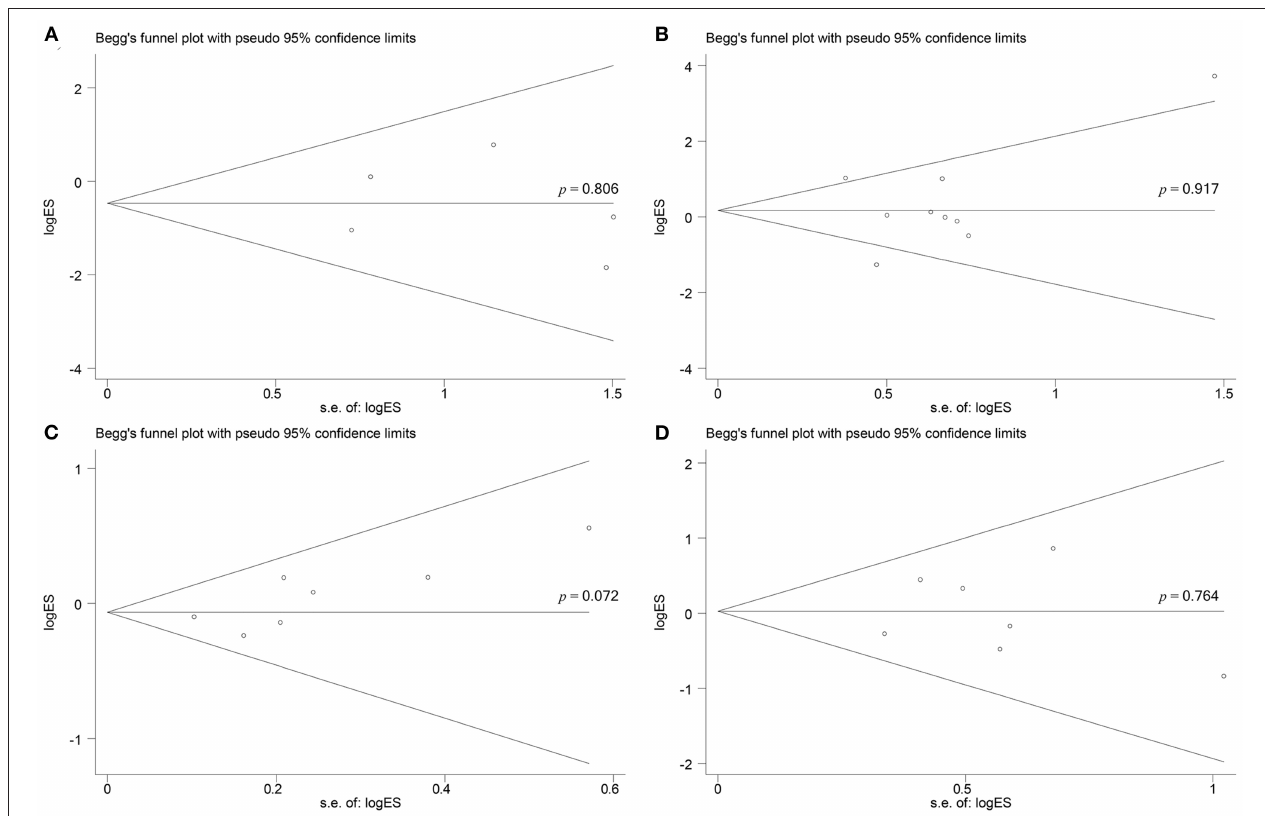
FIGURE 8 | Begg’s test for does not indicate any evidence of publication bias. (A) Begg’s funnel plot with pseudo 95% confidence limits in complete ablation rate ( p = 0.806). (B) Begg’s funnel plot with pseudo 95% confidence limits in complications ( p = 0.917). (C) Begg’s funnel plot with pseudo 95% confidence limits in total recurrence rate ( p = 0.072). (D) Begg’s funnel plot with pseudo 95% confidence limits in intrahepatic recurrence rate ( p =